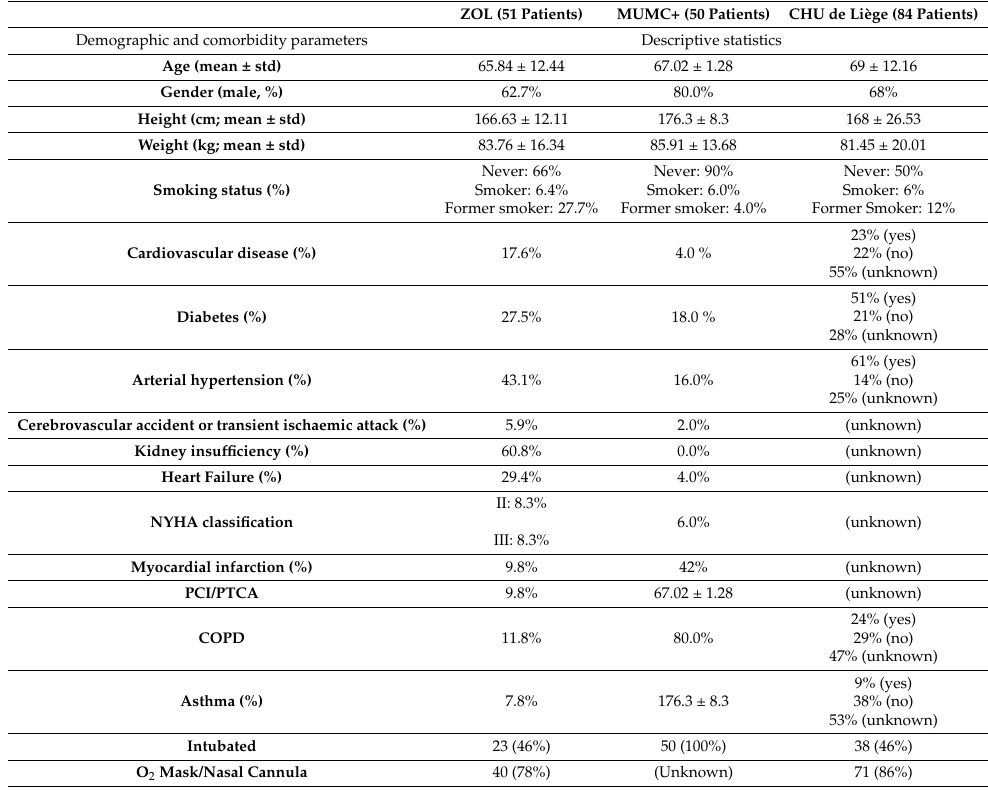
Table 1. The demographic presentation and most frequent comorbidities (prior to or acquired during their COVID infection) of the patients admitted to ICU in the three hospitals: ZOL, MUMC+, and CHU de